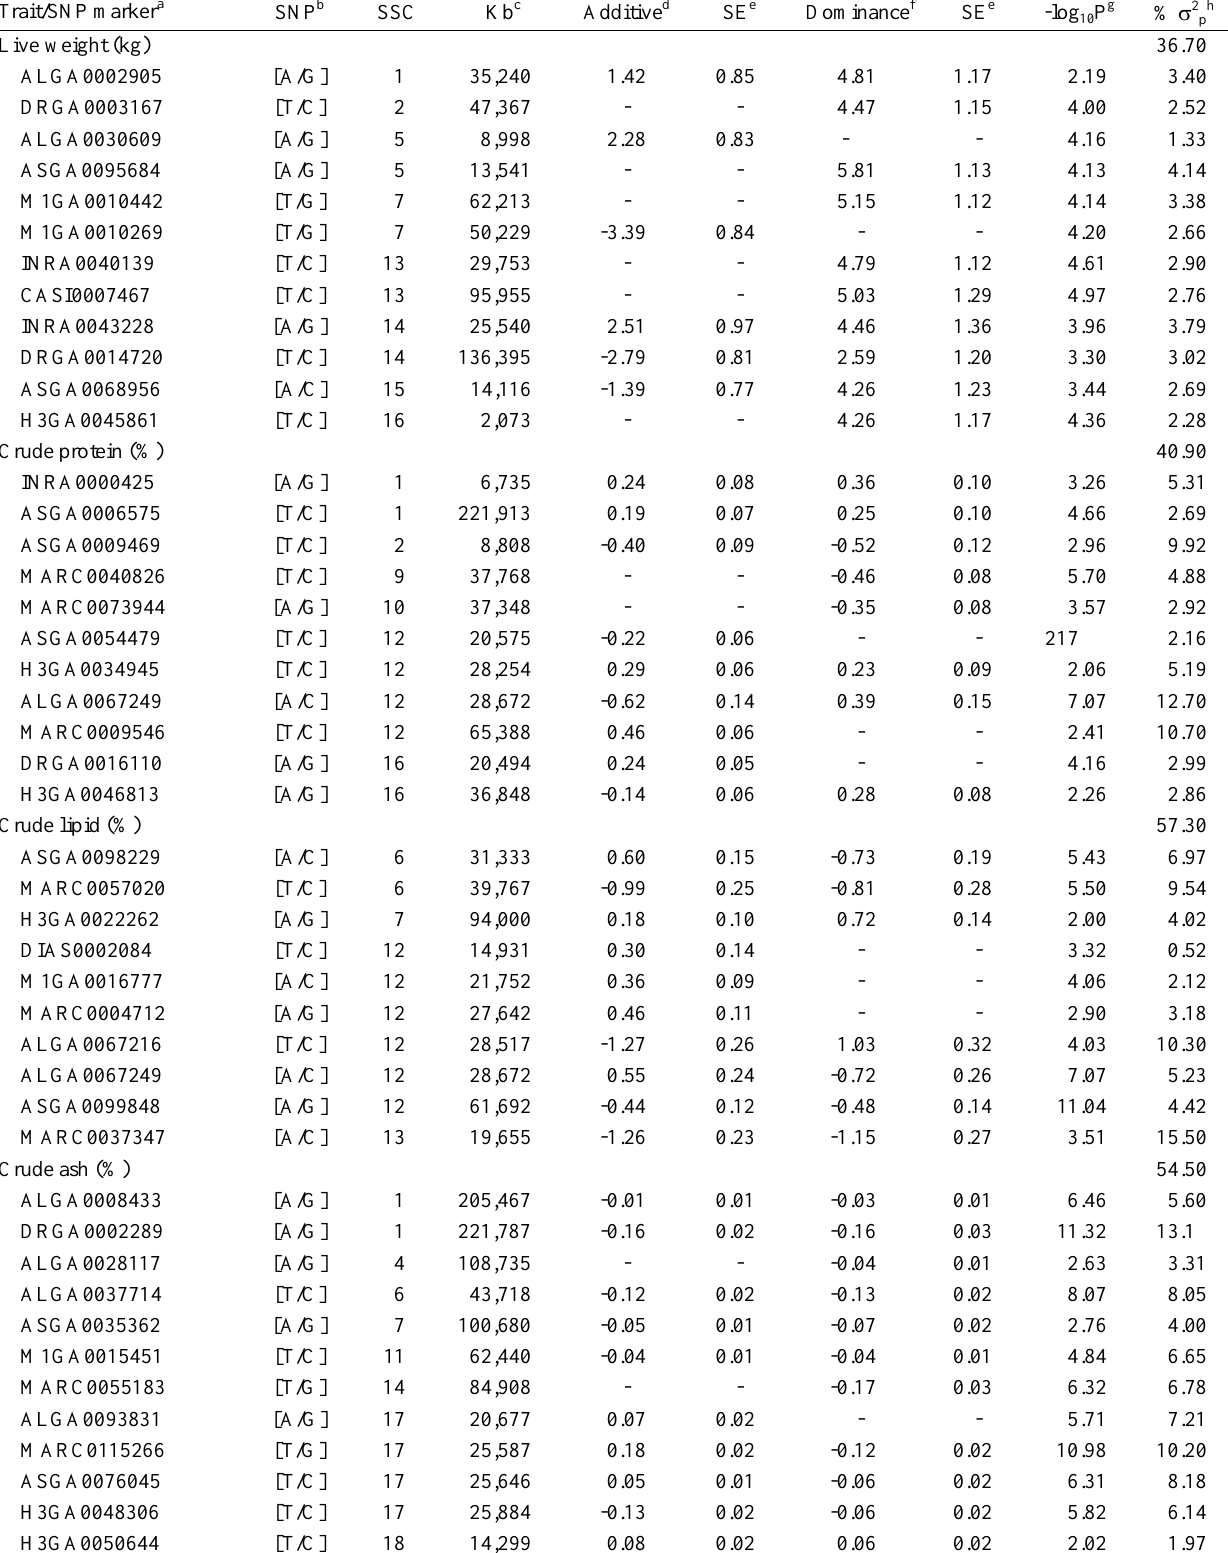
Table 3. Identities, positions of the SNPs with significant effects on meat quality traits in a Korean native pig and Landrace cross population Trait/SNP marker